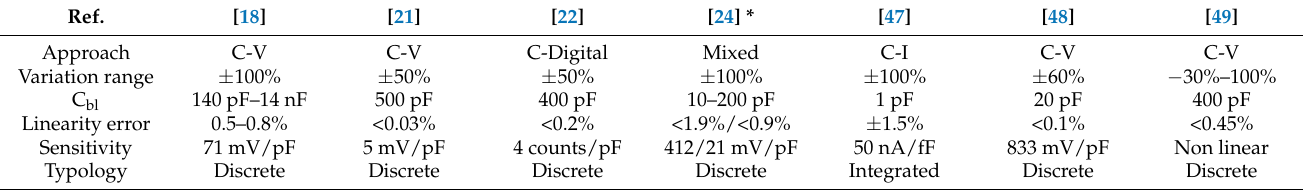
Table 1. Comparison between a VCII-based read-out circuit for differential capacitive sensors and conventional